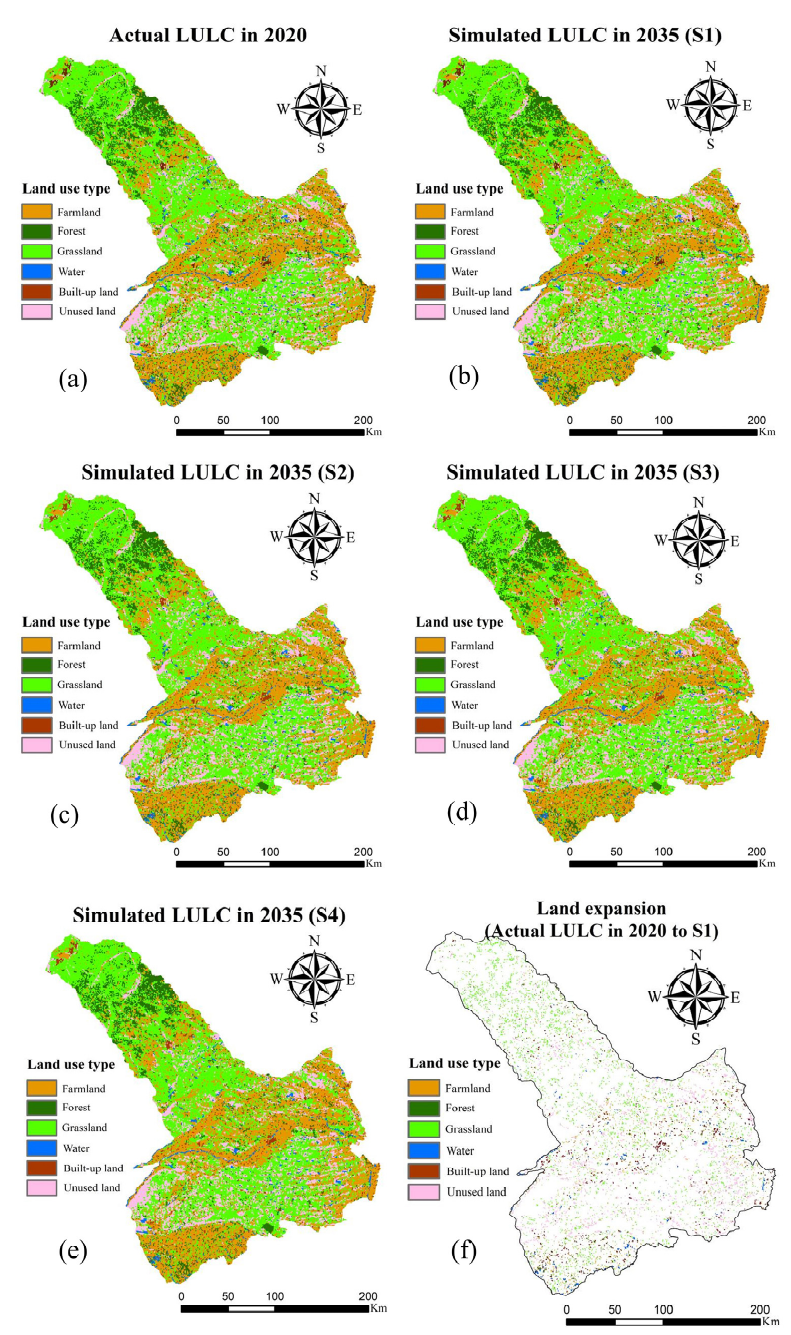
Figure 7. LULC maps for 2035 under different scenarios. ( a ) Actual LULC in 2020. ( b ) Simulation result of S1. ( c ) Simulation result of S2. ( d ) Simulation result of S3. ( e ) Simulation result of S4. ( f ) Land expansion of actual LULC in 2020 to S1.